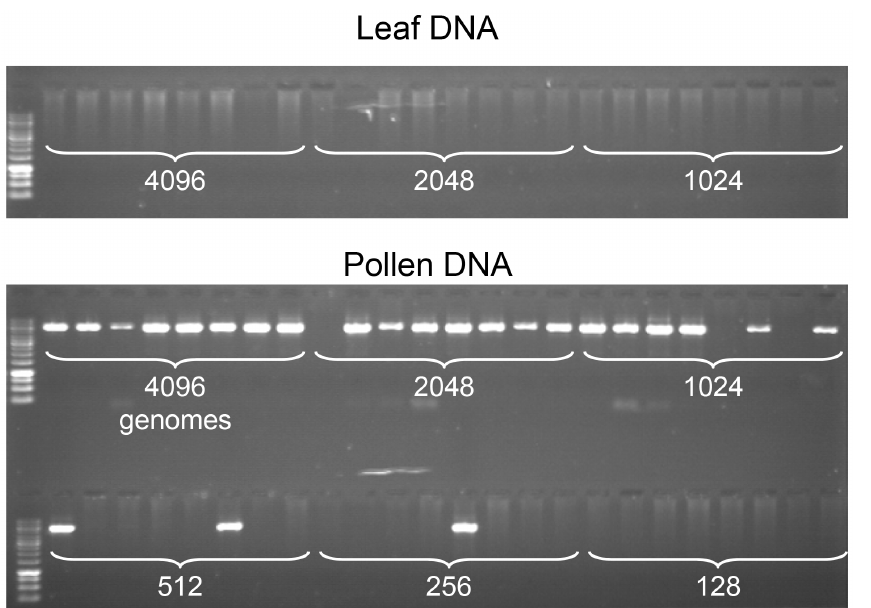
Figure 2. Specific detection of CO molecules in genomic DNA extracted from pollen. PCR was performed with allele-specific oligonucleotides (ASOs) designed for the amplification of CO molecules (see Material and Methods, Figure 1), using decreasing amounts of genomic DNA (the number of template molecules is indicated on the photograph) extracted from F1 Col x L er hybrid plants, either from leaf (two top rows) or pollen (two bottom rows). Eight aliquot reactions were carried out for each dilution. No PCR products were amplified from leaf. However, using equivalent low concentrations of DNA extracted from pollen (4096 molecules and less), CO molecules were strongly and specifically amplified .